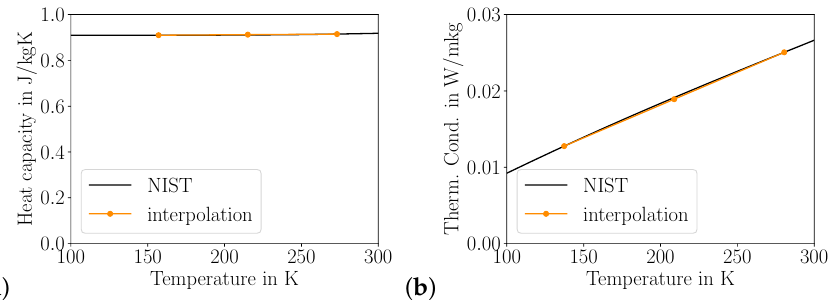
Figure 10. Comparison of interpolation to physical data for ideal gas. Data from NIST database [38] for oxygen at 0.01 MPa, i.e., at ideal gas conditions. ( a ) Comparison of isobaric heat capacity. ( b ) Comparison of thermal